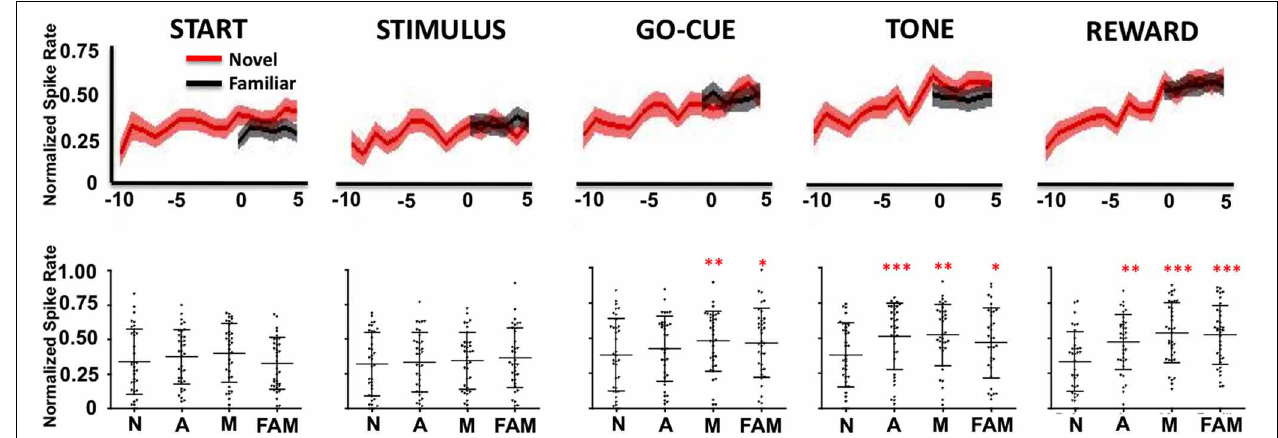
FIGURE 3 | Neuronal firing rates for Class I neurons ( n = 39) relative to learning. The upper row illustrates the average normalized firing rate (mean ± s.e.m. spikes per second; y-axis) of Class I neurons from ten trials ( t = − 10) before, to five trials ( t = 5) after learning for novel objects (red lines) and for familiar objects (black lines). The column labels represent the epoch (e.g., Start, Stimulus, etc.). The lower row